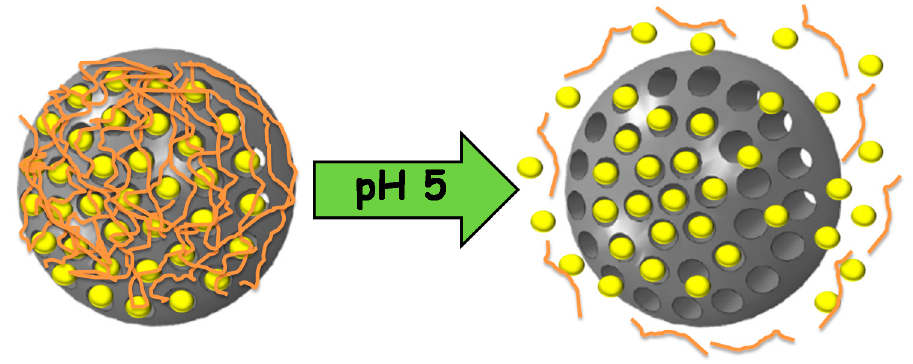
Figure 6. Mesoporous silica nanoparticles capped with self-immolative polymers that disassemble at acidic pH, triggering the release of the cargo.